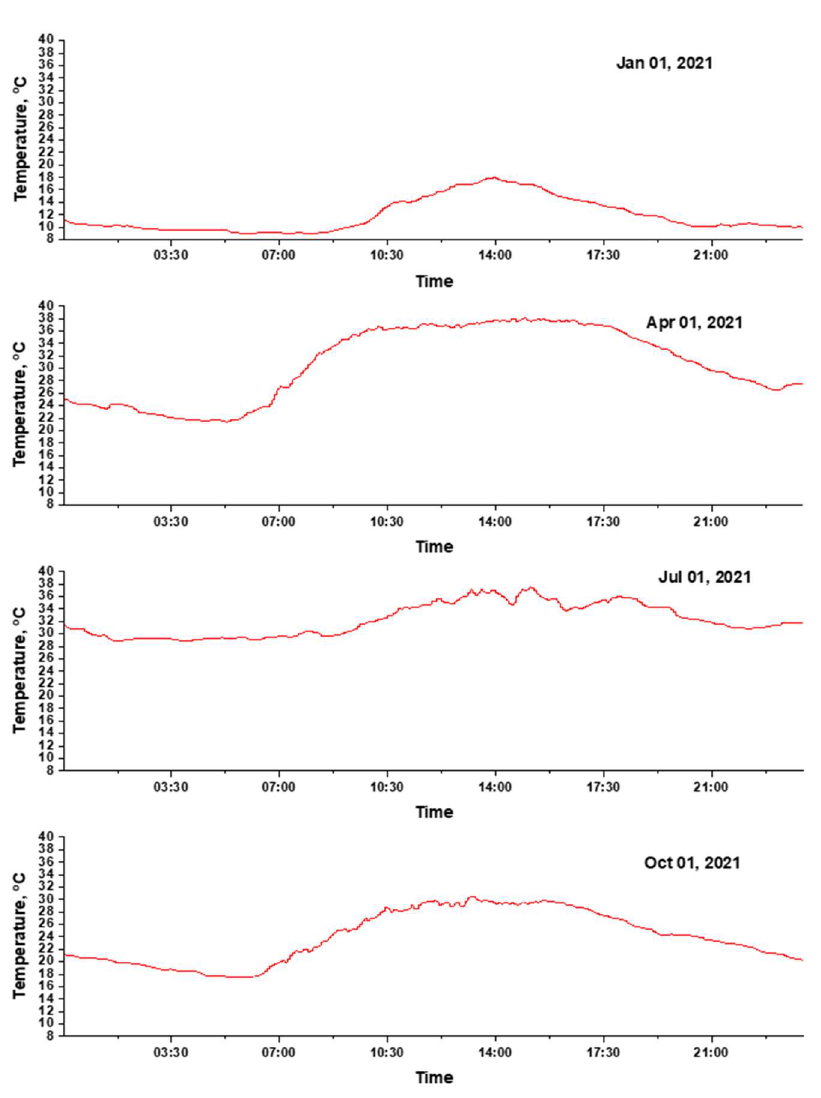
Figure 4. Daily measurements of ambient temperature for four selected days.